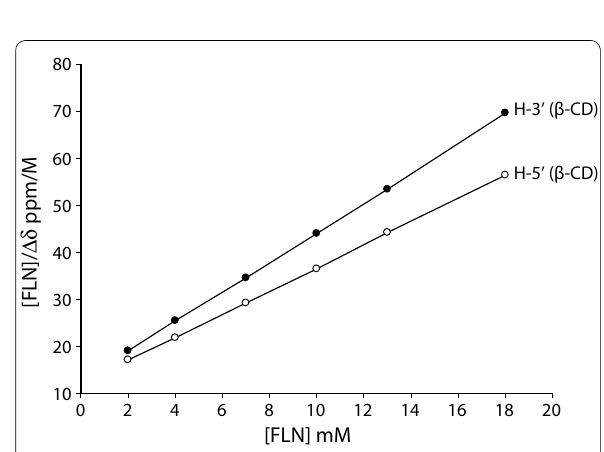
Fig. 7 Scott’s plot showing 1:1 stoichiometry for the β-CD-FLN